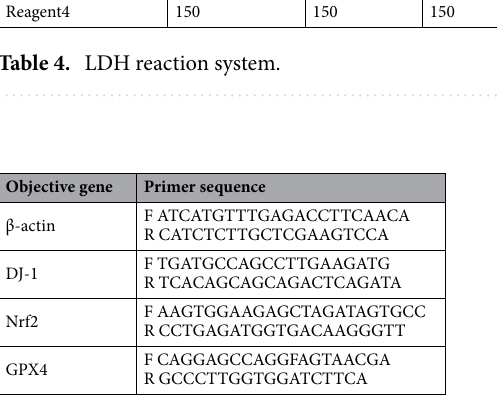
Table 5. Primer information in cell